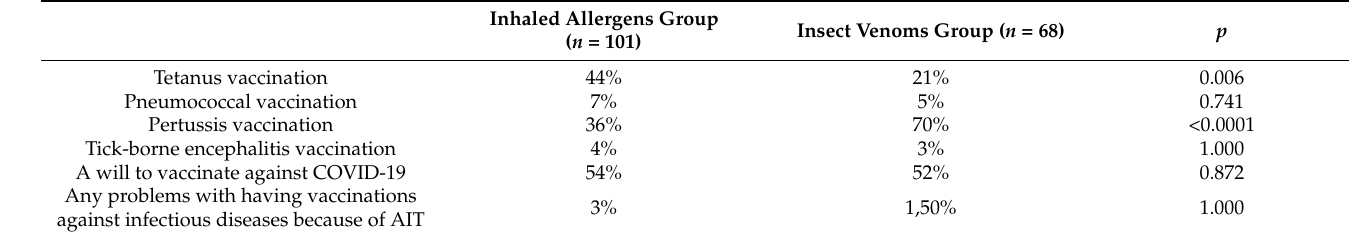
Table 3. The history of other vaccinations in adulthood (irrespective of AIT) and attitude towards vaccines against COVID-19 among patients undergoing allergen immunotherapy.